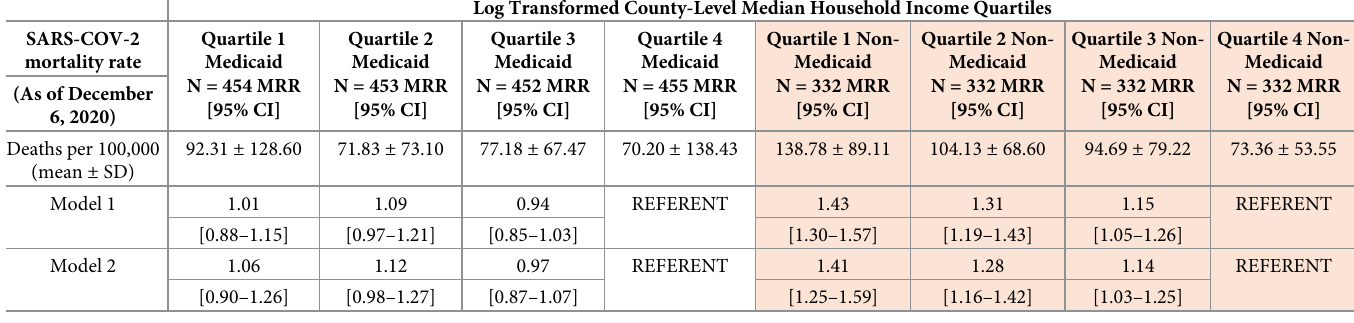
Table 4. Subgroup analysis of Medicaid and non-Medicaid SARS-COV-2 mortality rate as of December 6, 2020 with county-level median household income quartiles.